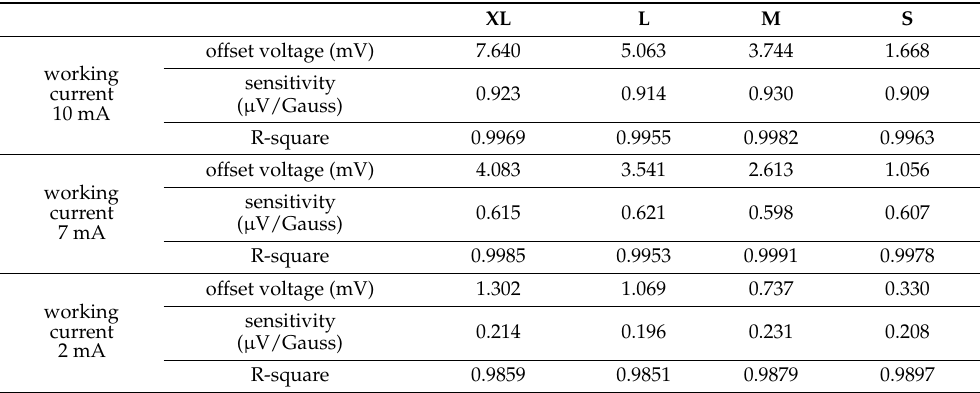
Table 1. Offset voltage, sensitivity, and coefficients of determination of four sizes of Hall sensors under three different working currents.